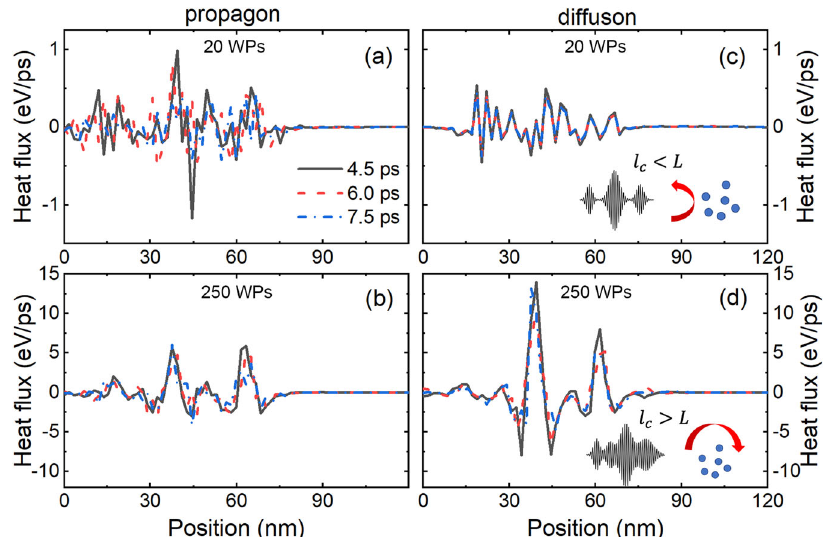
Fig. 3 Heat fl ux distribution. The simulated heat fl ux for the cases where propagons are excited with ( a ) 20 wave-packets and ( b ) 250 wave- packets at 4 ps. The simulated heat fl ux for the cases where diffusons are excited with ( c ) 20 wave-packets and ( d ) 250 wave-packets at 4 ps. The inset of fi gure ( c ) shows the schematic of a low-density ensemble of wave-packets re fl ected by the local disorder. The inset of ( d ) shows the schematic of a high-density ensemble of coherent diffuson wave-packets propagating through the local disorder.